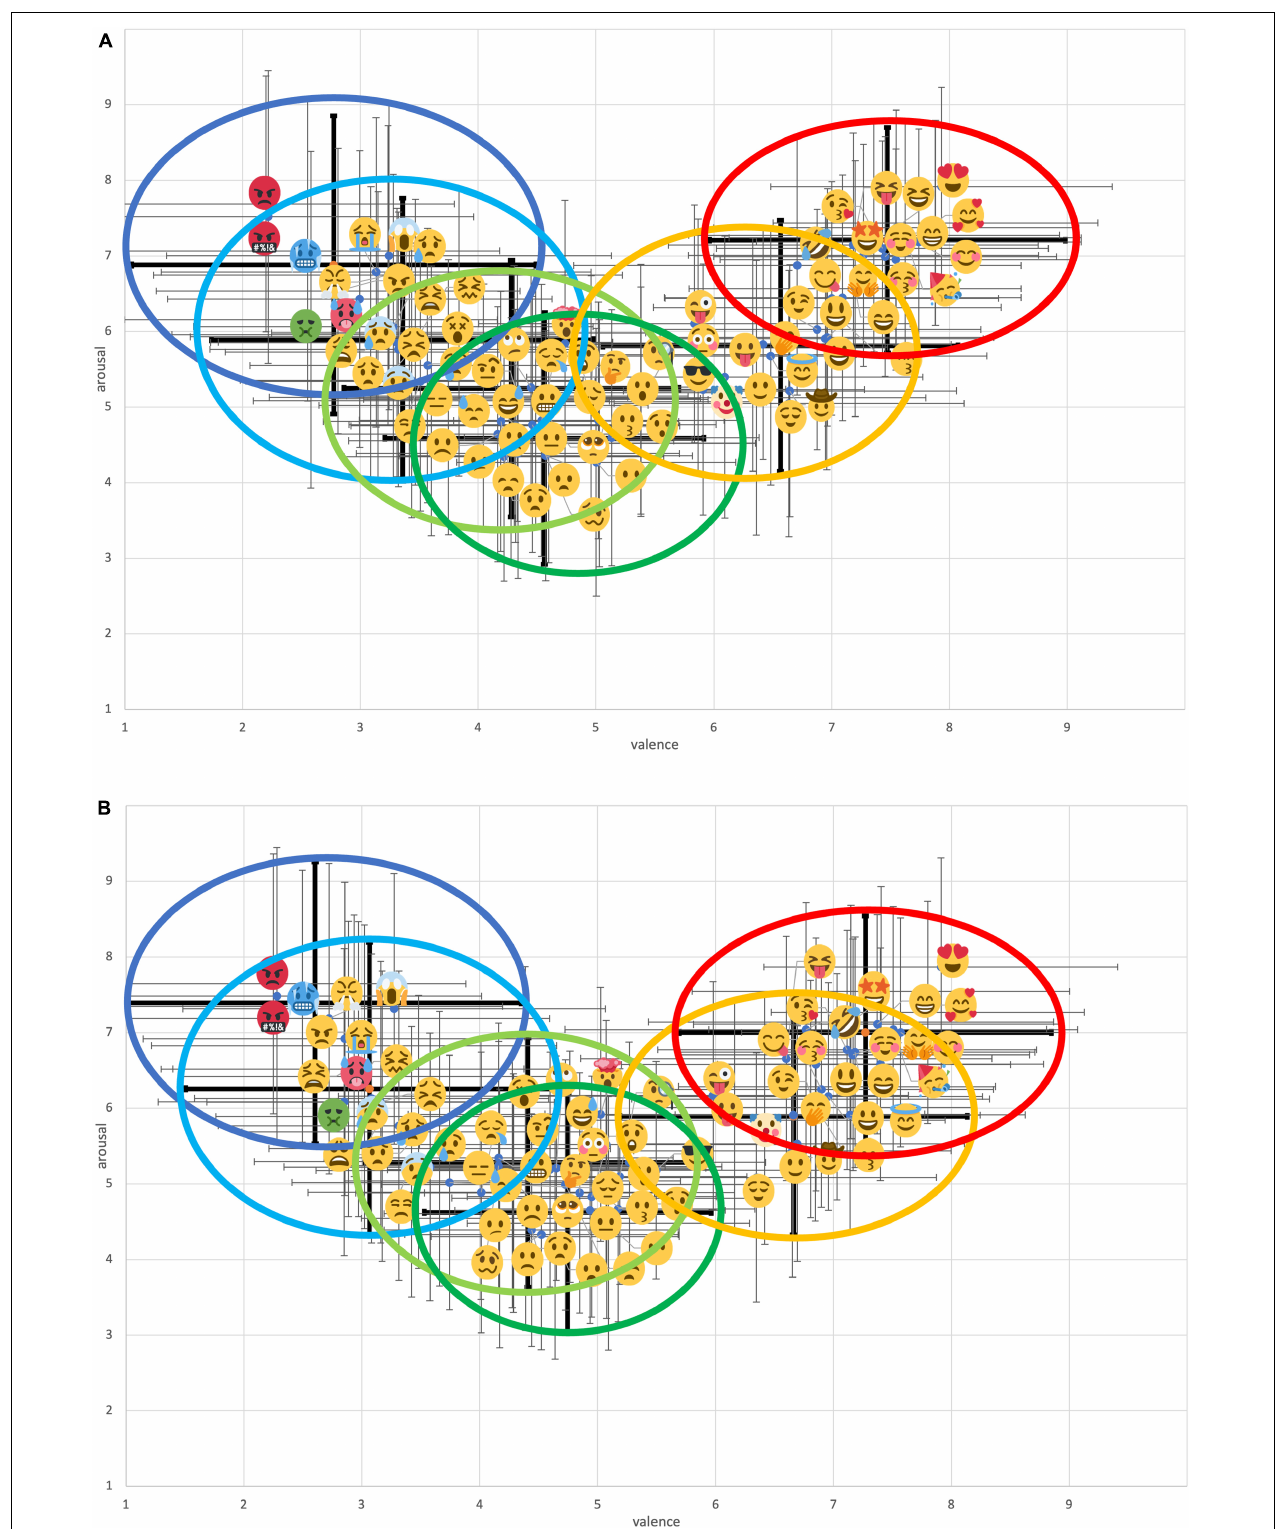
FIGURE 2 | Comparison of (A) mean arousal and (B) mean valence scores for each cluster per age group. Error bars are ± 1 standard deviation of the mean. Asterisks indicate significant differences between age groups. Each letter indicates post hoc results (Bonferroni corrected) between clusters, with clusters of similar letters being not significantly different at 5%. The “ n ” in the bar chart represents the number of emojis belonging to each cluster.